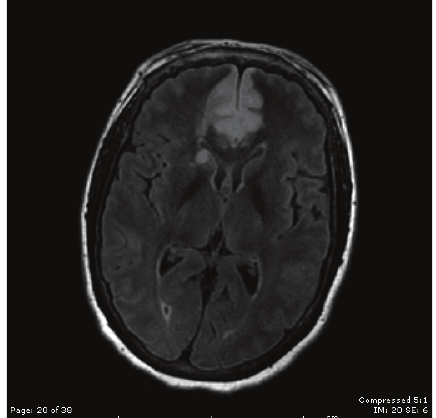
Figure 3: FLAIR MRI showing hyperintense lesion bilateral ACA territory and head of caudate on right